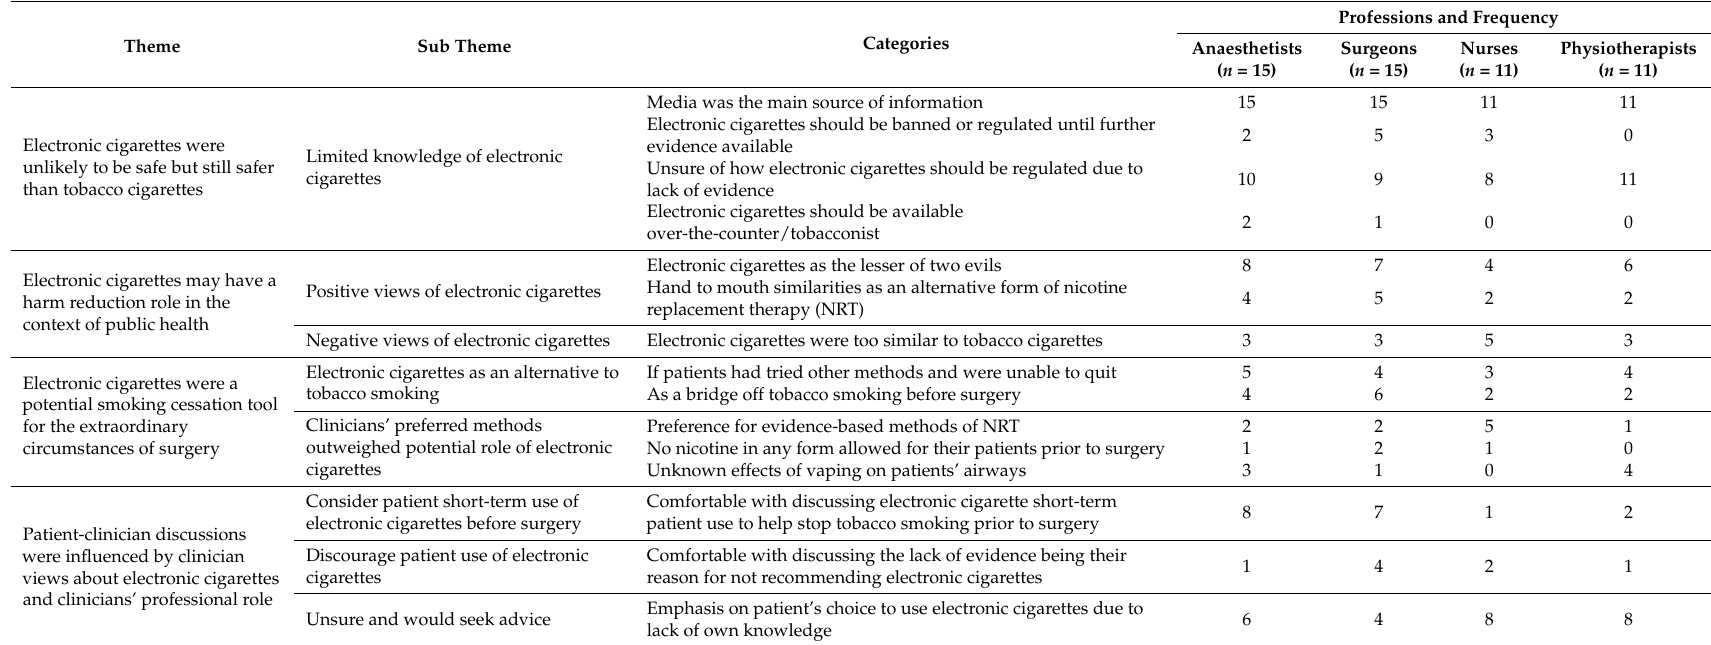
Table 2. Themes relevant to clinicians’ views of electronic